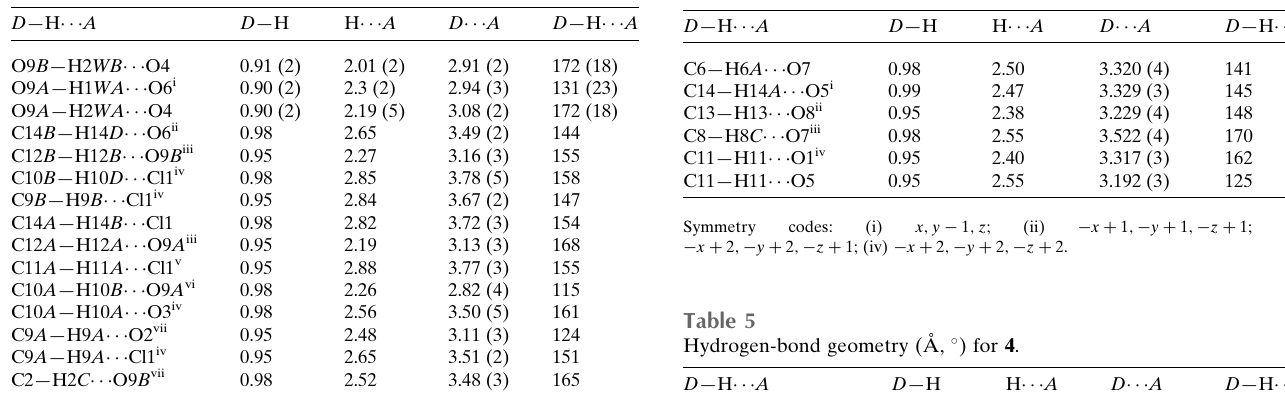
Table 4 Hydrogen-bond geometry (A˚ , (cid:5) ) for 3 .